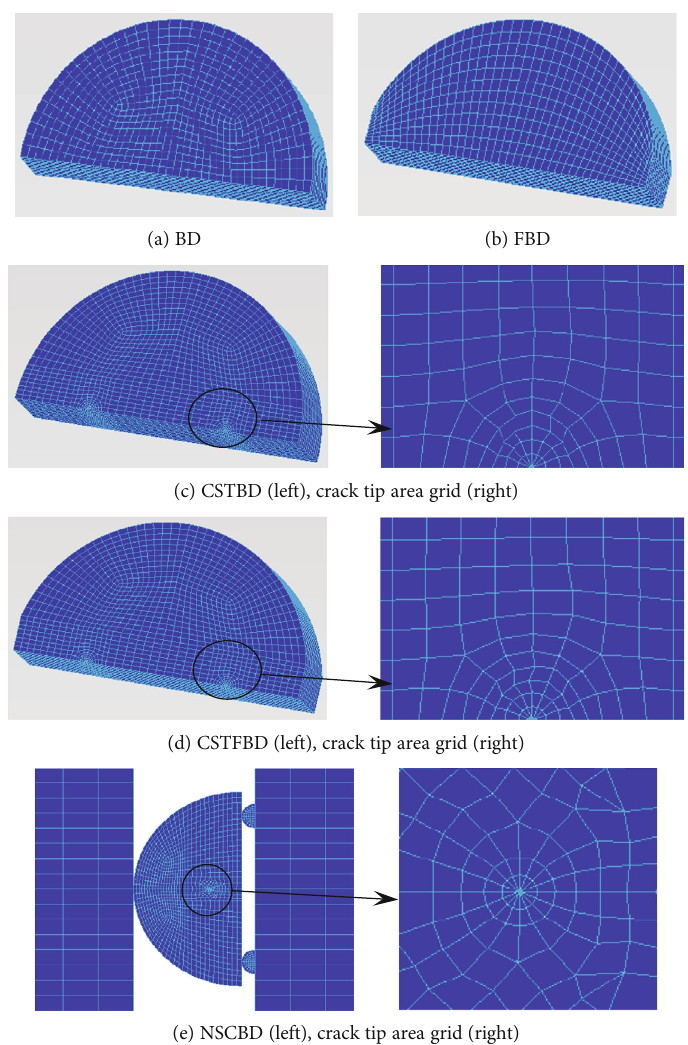
Figure 4: Five con fi guration specimen